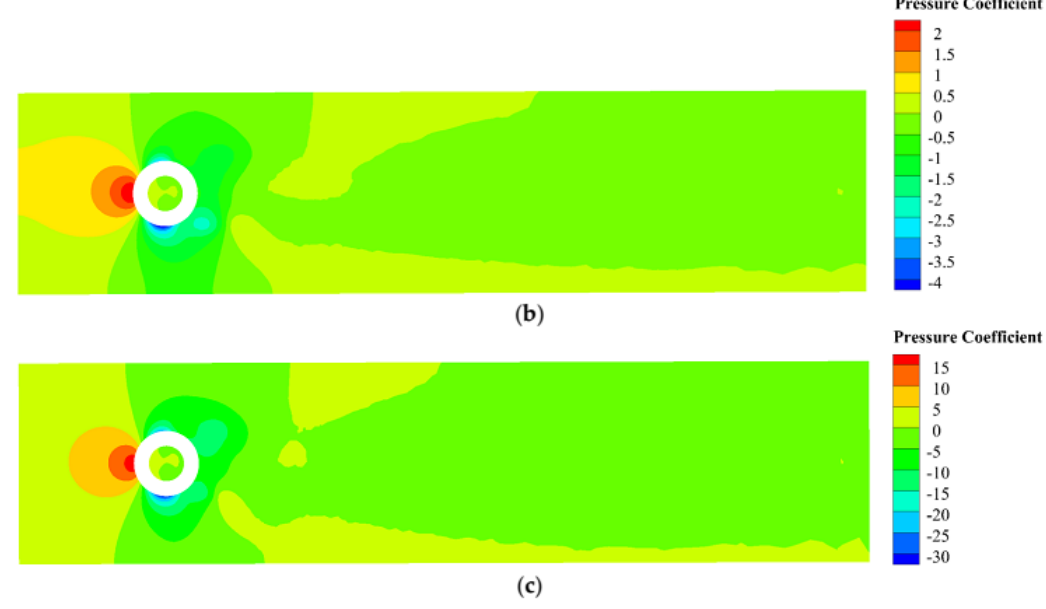
Figure 18. Distribution of pressure coefficient in xy-plane for different inlet wind velocities: ( a ) 0.1 m/s; ( b ) 1.5 m/s; and ( c ) 4 m/s. Table 3. Outlet mass flow rate from the wind tower in different wind